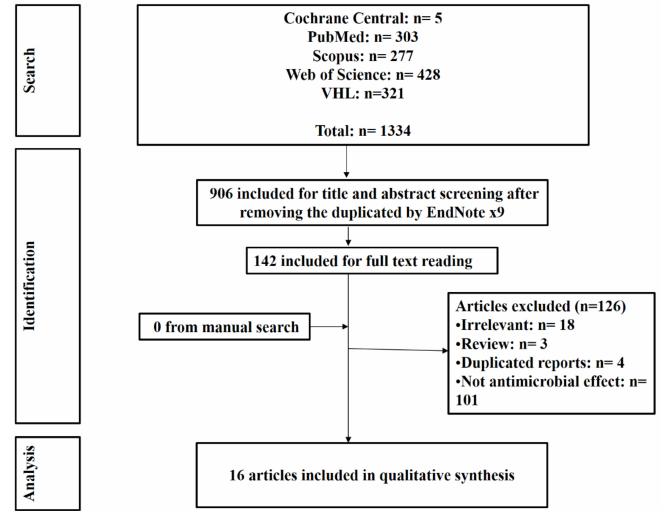
Figure 1. Flow diagram of included